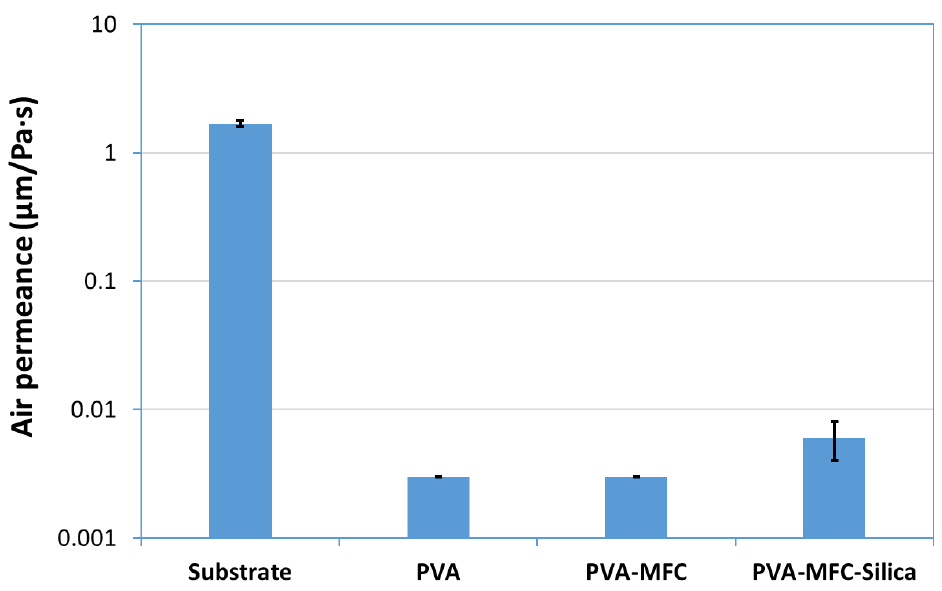
Figure 3. Air permeance of the substrate and coated samples.